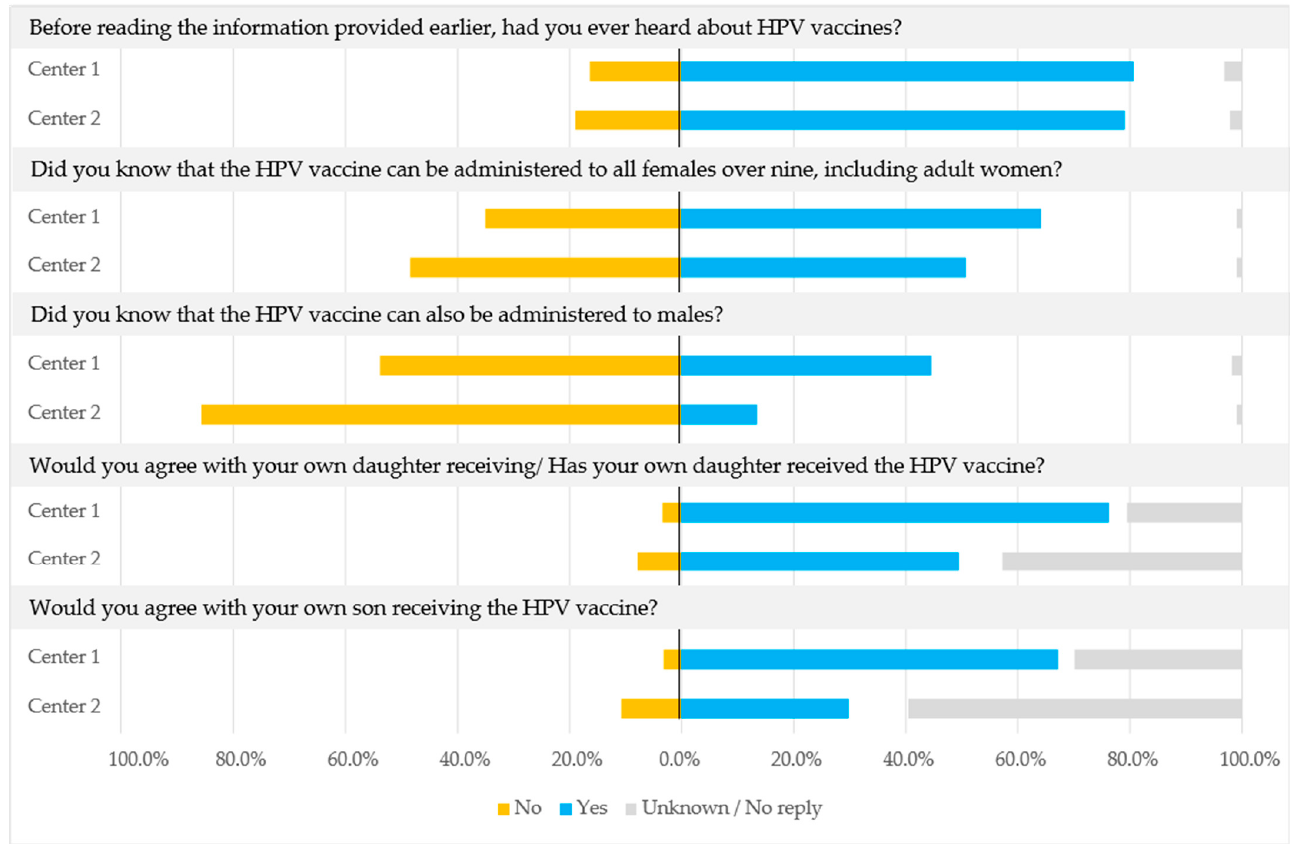
Figure 2. Knowledge about HPV vaccine administration and willingness to vaccinate children against HPV at Center 1 and Center 2, expressed as a proportion of all participants at each center. Participants were asked to reply to the last two questions even if they did not have children.